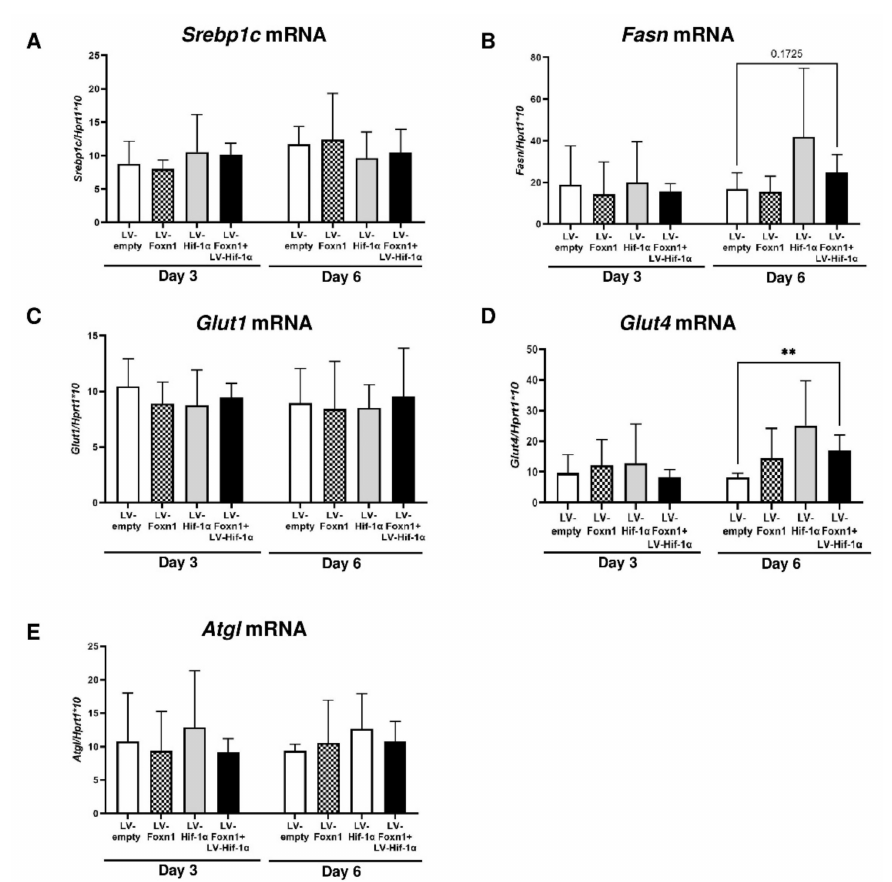
Figure 7. Quantitative RT-PCR mRNA expression analysis of genes related to lipogenesis: Srebp1c ( A ), Fasn ( B ), Glut1 ( C ) and Glut4 ( D ), or lipolysis: Atgl ( E ). Data represents mean ± SD, n = 4 mice per group/per time point (** p <